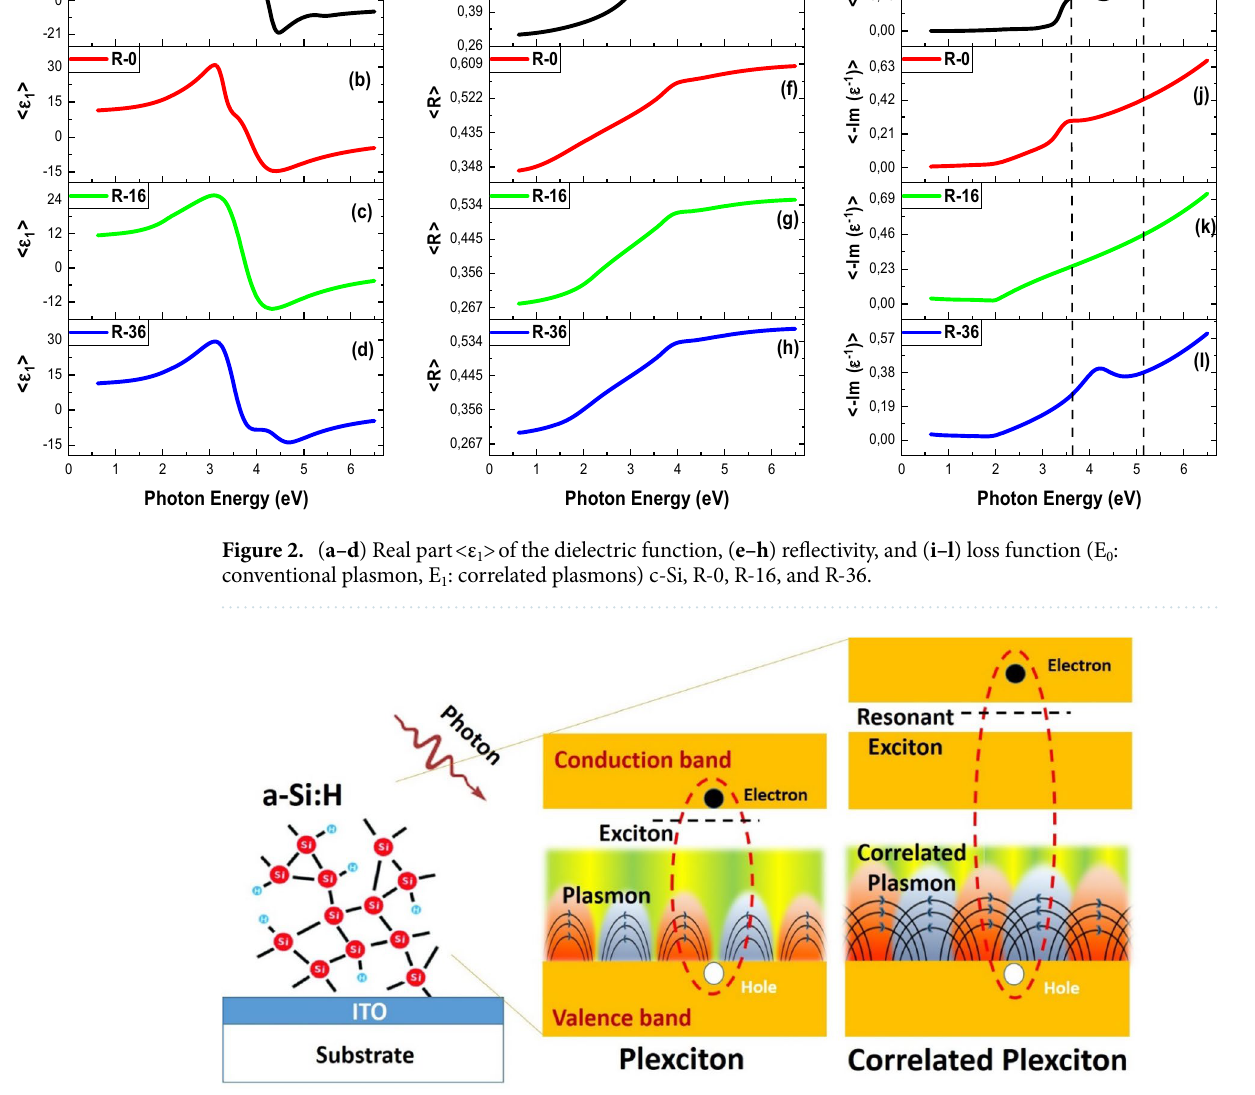
Figure 3. Schematic diagram of the coupling mechanism of correlated plasmon and resonant